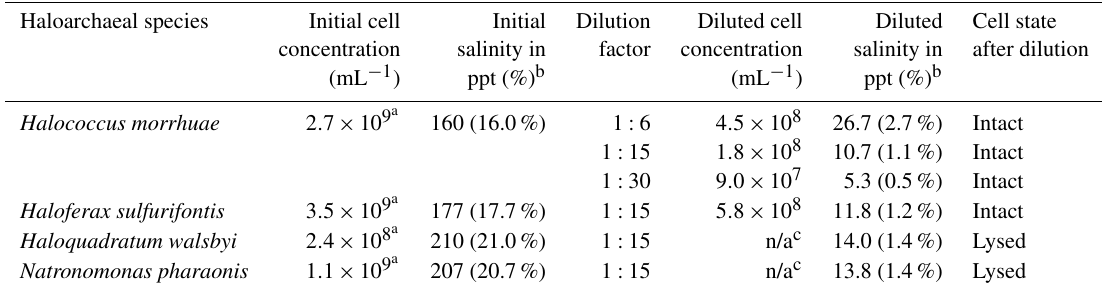
Table 1. Samples produced from all four haloarchaeal species for ice nucleation testing. Initial sample cell concentrations and salinities are provided after culturing. Diluted cell concentrations and salinities were calculated based on the volume of culture mixed with media and dilution factor. The cell state is also provided after dilution. Haloarchaeal species Initial cell Initial Dilution Diluted cell Diluted Cell state concentration salinity in factor concentration salinity in after dilution (mL − 1 ) ppt (%) b (mL − 1 ) ppt (%) b Halococcus morrhuae 2 . 7 × 10 9 a 160 (16.0%) 1 : 6 4 . 5 × 10 8 26.7 (2.7%) Intact 1 : 15 1 . 8 × 10 8 10.7 (1.1%) Intact 1 : 30 Intact Haloferax sulfurifontis 3 . 5 × 10 9 a 177 (17.7%) 1 : 15 11.8 (1.2%) Intact Haloquadratum walsbyi 2 . 4 × 10 8 a 210 (21.0%) 1 : 15 n/a c 14.0 (1.4%) Lysed Natronomonas pharaonis 1 . 1 × 10 9 a 207 (20.7%) 1 : 15 n/a c 13.8 (1.4%)